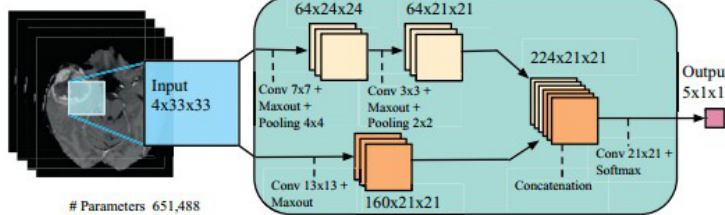
Figure 15. Model Architecture (reproduced from [103] with permission).